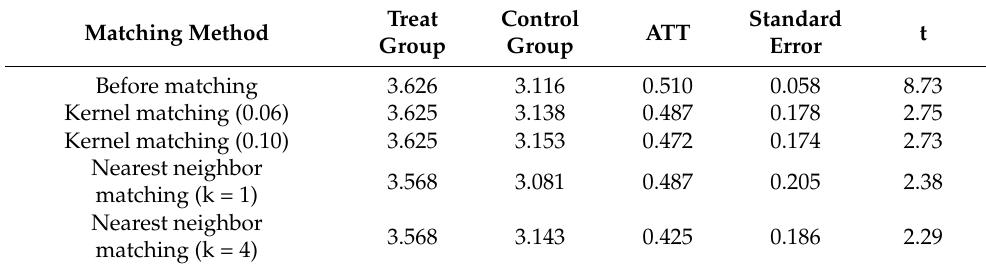
Table 9. Treatment effects (ATT) using matching